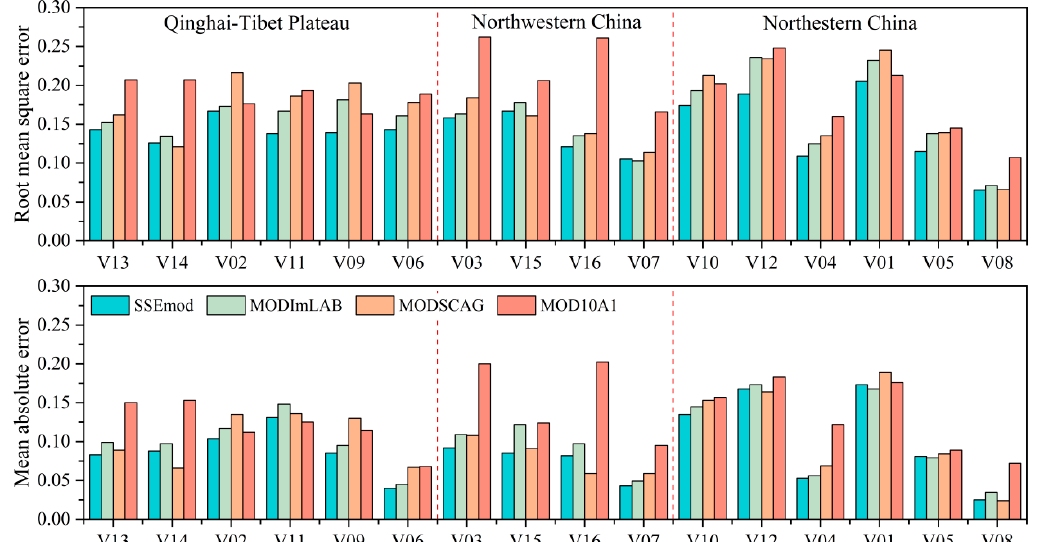
Figure 8. The accuracy validation result of the fractional metric of SSEmod, MODImLAB, MODSCAG, and MOD10A1 FSC.